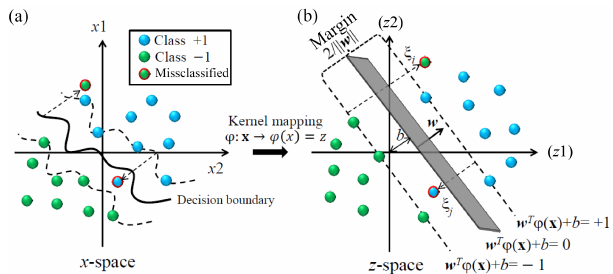
Figure 1. Graphical presentation of the support vector machine classifier with a non-linear kernel, (a) complex binary pattern clas- sification problem in input space, and (b) non-linear mapping into high-dimensional feature space where a linearly separable data clas- sification takes